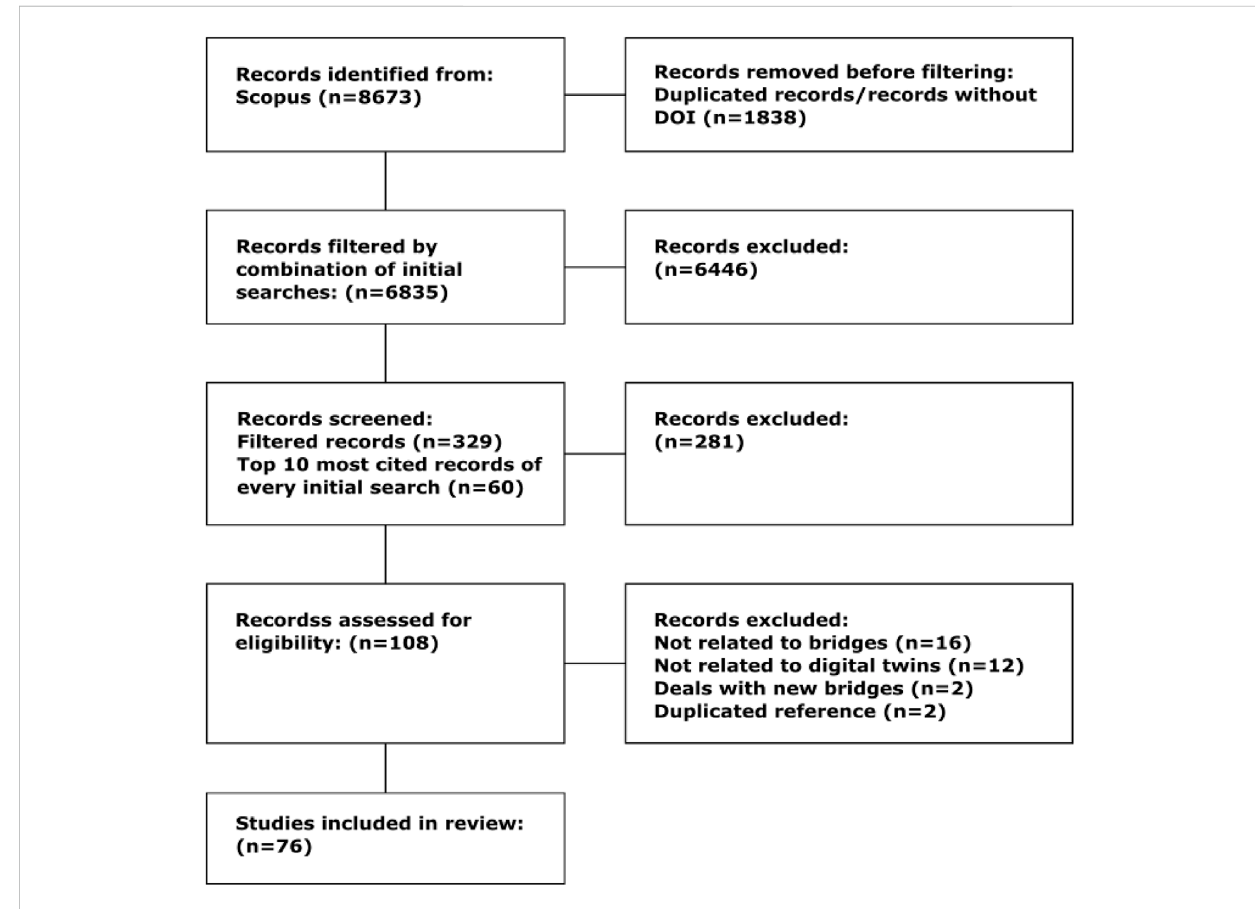
FIGURE 1 PRISMA fl ow